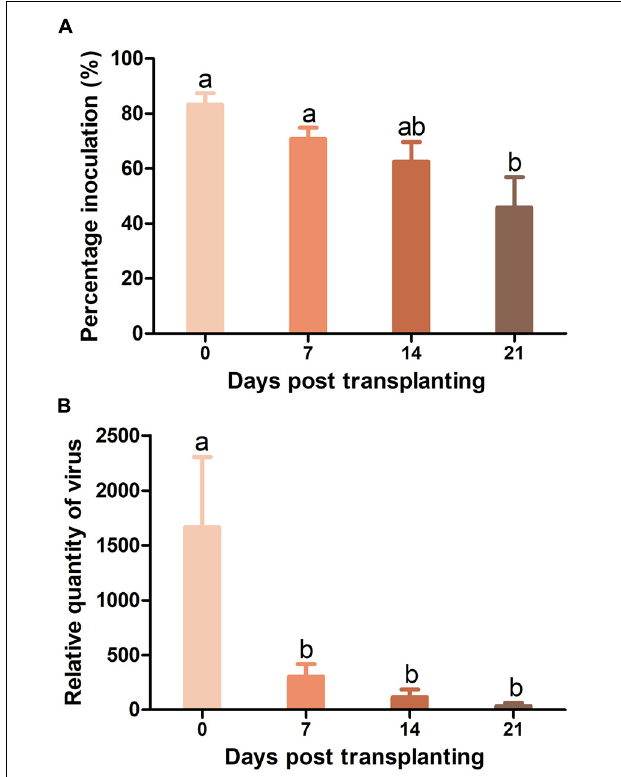
FIGURE 3 | Resistance to tomato yellow leaf curl virus (TYLCV) in Pufen7 seedlings of 0, 7, 14, and 21 DPT. (A) Percentage of TYLCV-infected plants in agro-inoculated plants; (B) Relative quantity of virus. Values are means ± SEM ( n = 3 and in each replicate 7–8 plants were used for panel (A) ; n = 8 for panel (B) ]. Different letters above the columns indicate significant differences (one-way ANOVA, p <